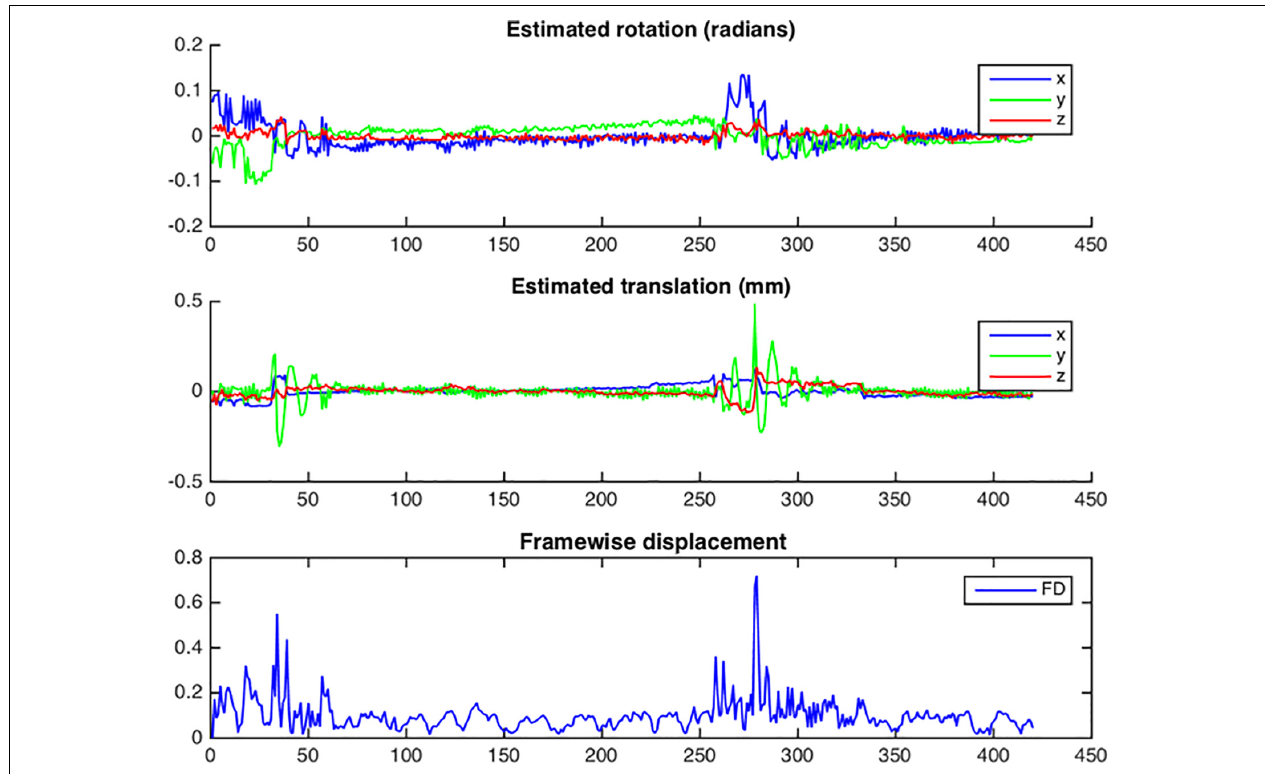
FIGURE 9 | Example of head motion plots from a single subject. Plots are generated for each bold run and contain three different graphs per run: estimated rotation in radians; estimated translation in millimeters; Framewise displacement in millimeters.